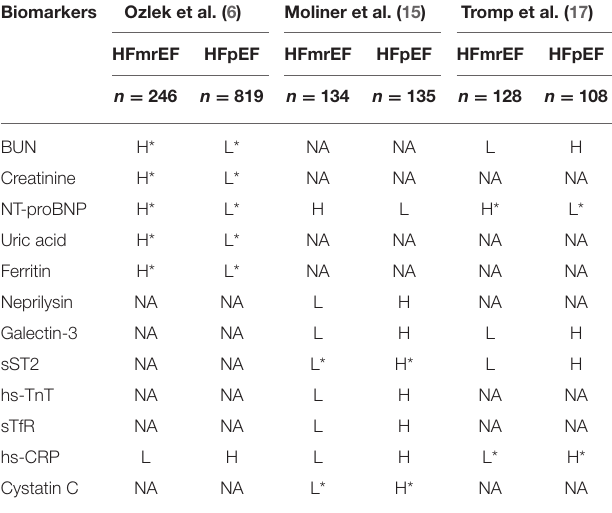
TABLE 2 | Clinical indicator of patients with HFmrEF and